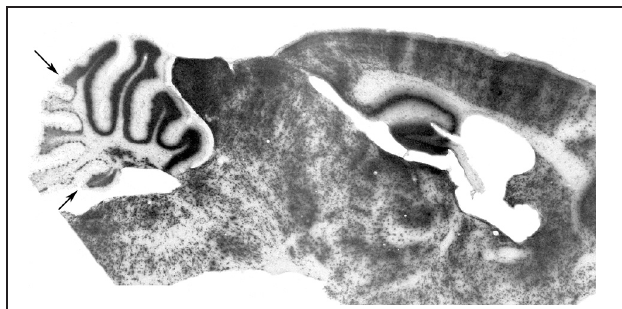
FIGURE 3 | Compartmentation of the granular layer. Cell transverse lineage boundaries seen in a β -gal-stained sagittal section through an adult murine embryonic stem cell chimera. The ES-cell-derived granule cells ( β -gal+) are concentrated preferentially in the anterior vermis (AZ) with a restriction boundary in lobule VI (AX/CZ: arrow), and in the nodulus with a boundary in the sulcus between lobules IX and X (the PZ/NZ boundary: arrow) [Adapted from Hawkes et al.